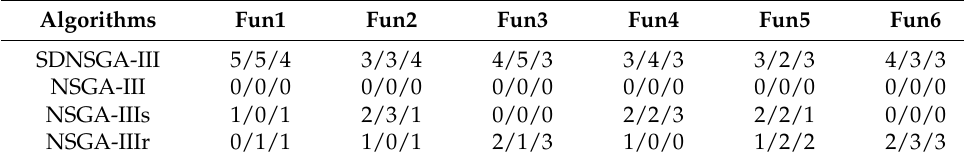
Table 6. The statistical results of six benchmarks on different metrics.